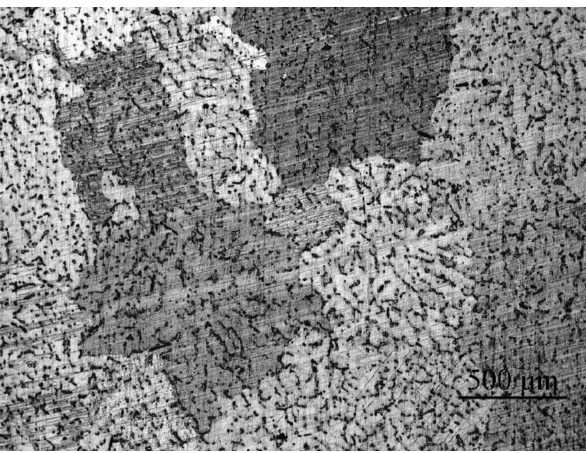
Figure 1: As-cast microstructure of AZ31 magnesium